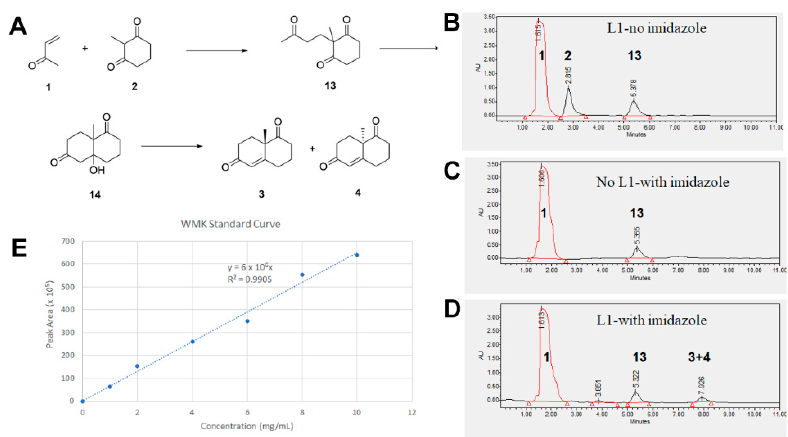
Figure 3. Investigation of reaction products in the presence and absence of imidazole and lipase preparation. ( A ) Starting materials 2-methyl-1,3-cyclohexanedione 1 and methyl vinyl ketone 2 produce triketone intermediate 13 , which proceeds through bicyclic species 14 to WMK products 3 and 4 . ( B ) HPLC chromatogram of reaction sample with L1 but no imidazole. ( C ) HPLC chromatogram of reaction sample with imidazole but no L1. ( D ) HPLC chromatogram of reaction sample with both L1 and imidazole. ( E ) Standard curve generated using HPLC data obtained from commercially available Wieland–Miescher ketone. Reaction conditions taken from [18].